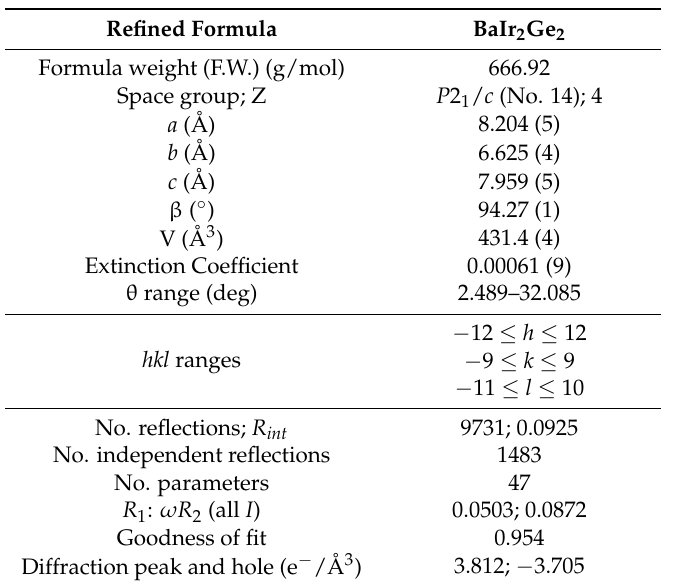
Table 1. Single crystal crystallographic data for BaIr 2 Ge 2 at 299 (2) K.